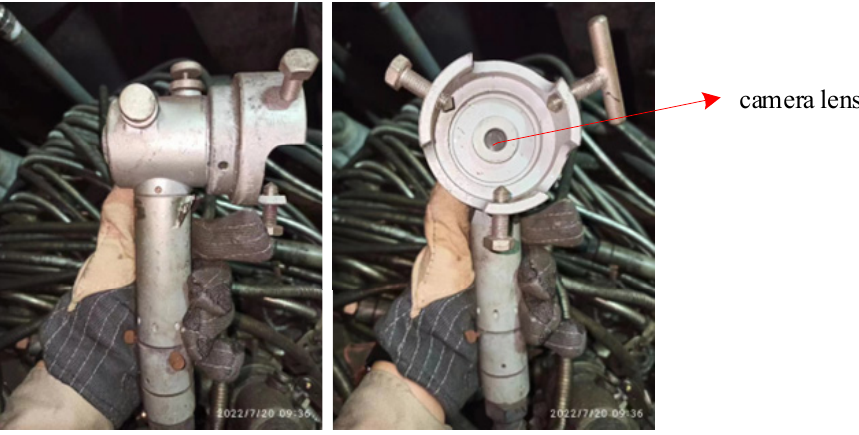
Figure 5. Blast furnace tuyere camera device. The categories of the blast furnace tuyere images are shown in Figure 6.